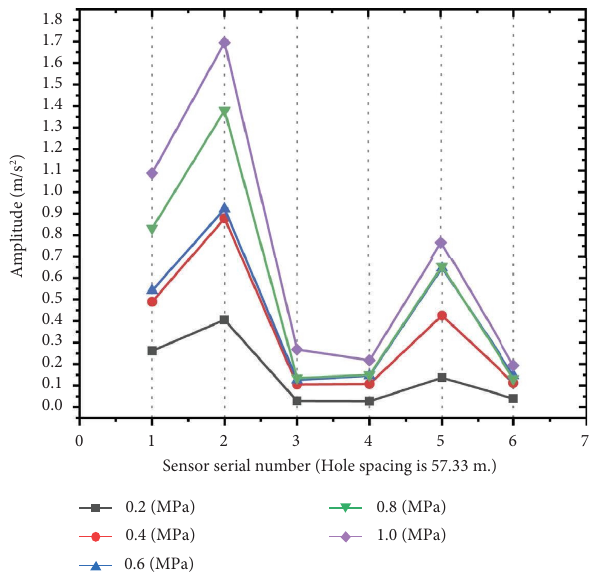
Figure 7: Variation of the amplitude of A and D leakage with the distance under diferent